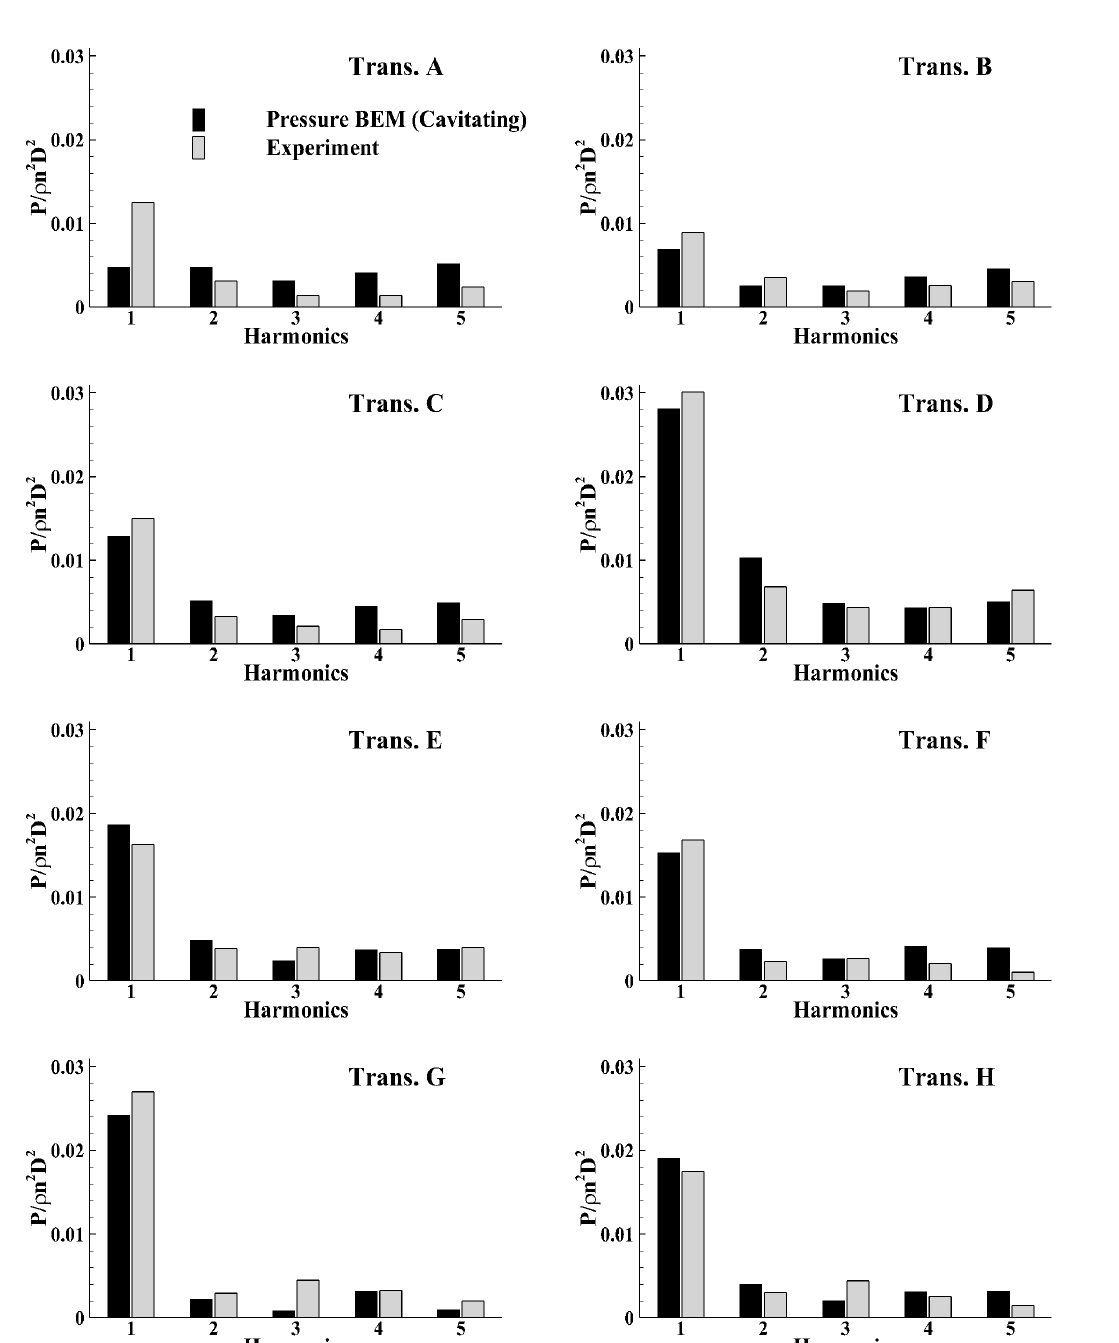
Figure 36. Comparisons of the pressure harmonics predicted by the BEM in cavitating conditions including the tip vortex cavitation model with the measurements